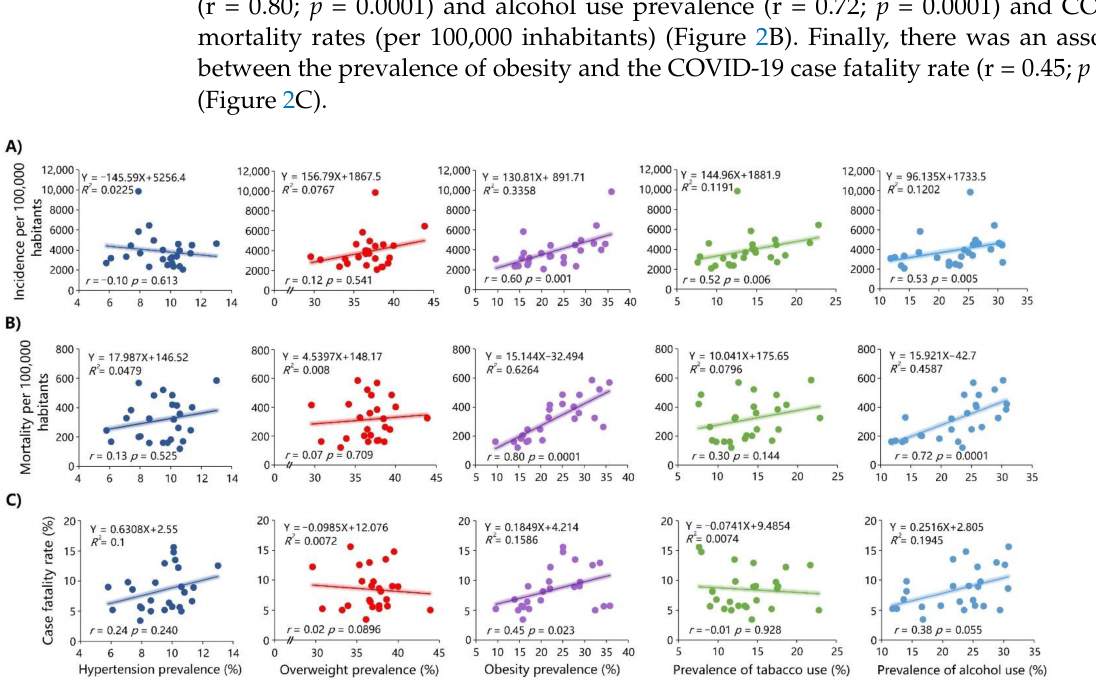
Figure 2. Linear regression models and Spearman correlation between the prevalence rates of hypertension, overweight, obesity, smoking, and alcohol use and the incidence rate ( A ), mortality rate ( B ), and case fatality rate due to COVID-19 ( C ) in 2020.